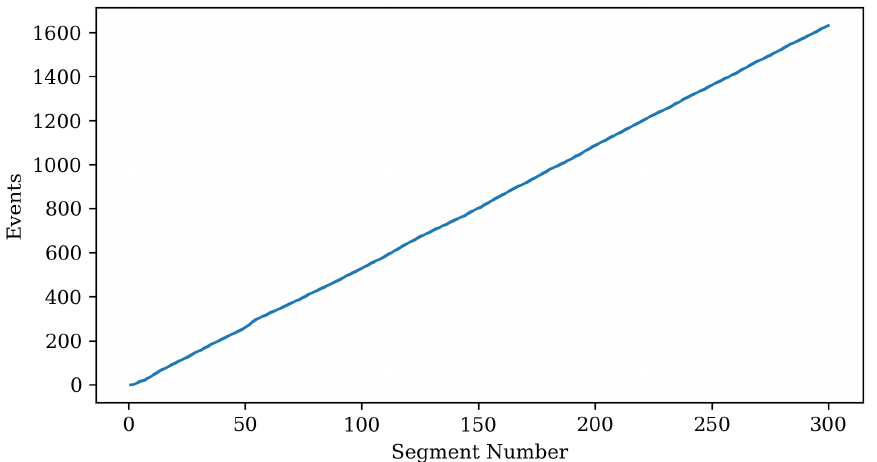
Figure 14. Replay buffer size. An event is a tuple stored in the replay buffer. It has state, performed action, reward, and changed state